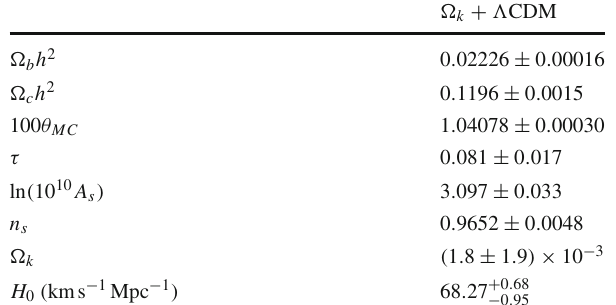
Table 4 The 68% limits for the cosmological parameters in the (cid:3) k + (cid:2) CDM model from P15 + BAO